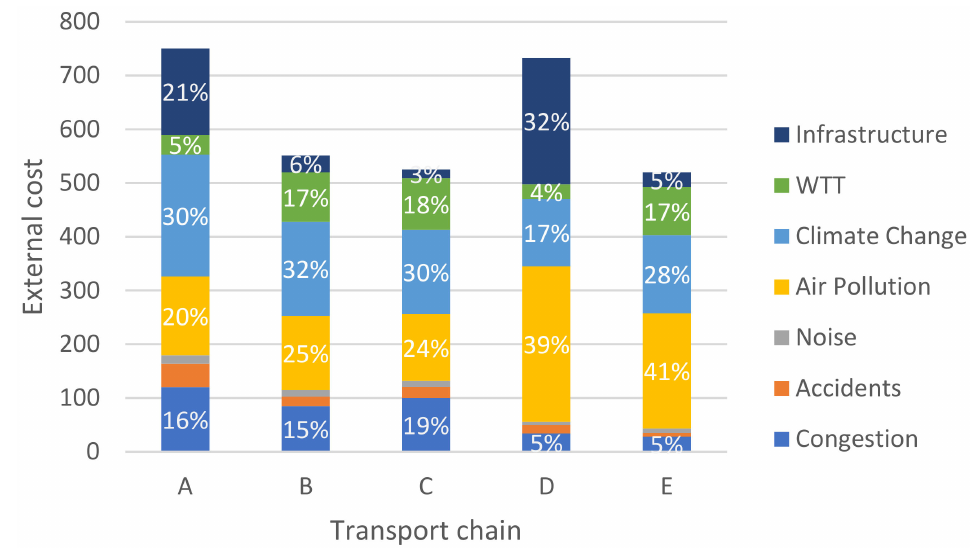
Figure 3. External costs ( € ) per cost type in the transport chains between Porto and Stuttgart.